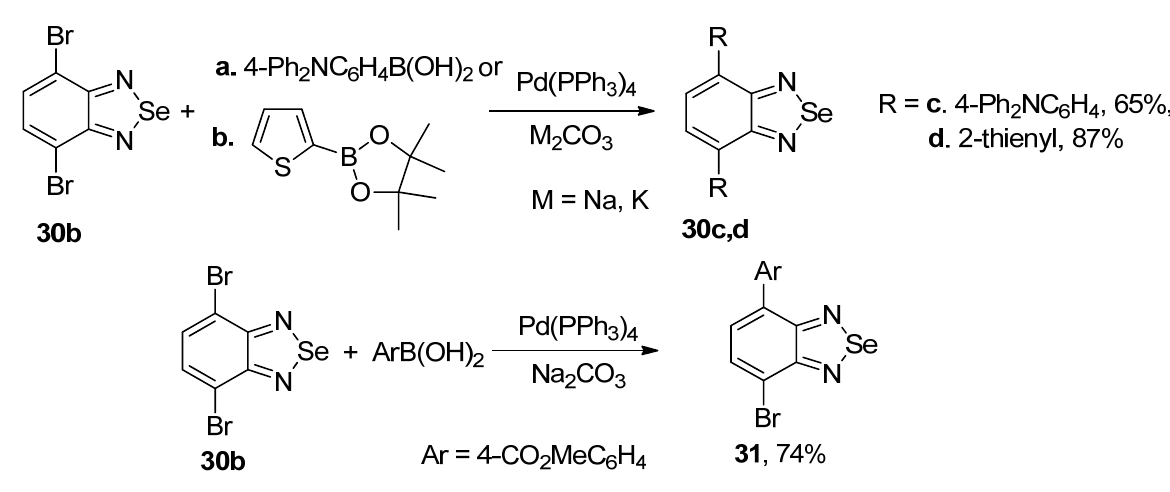
Scheme 16. Reaction of 4,7-dibromo-2,1,3-benzoselenadiazole 30b with arylboronic acids and their